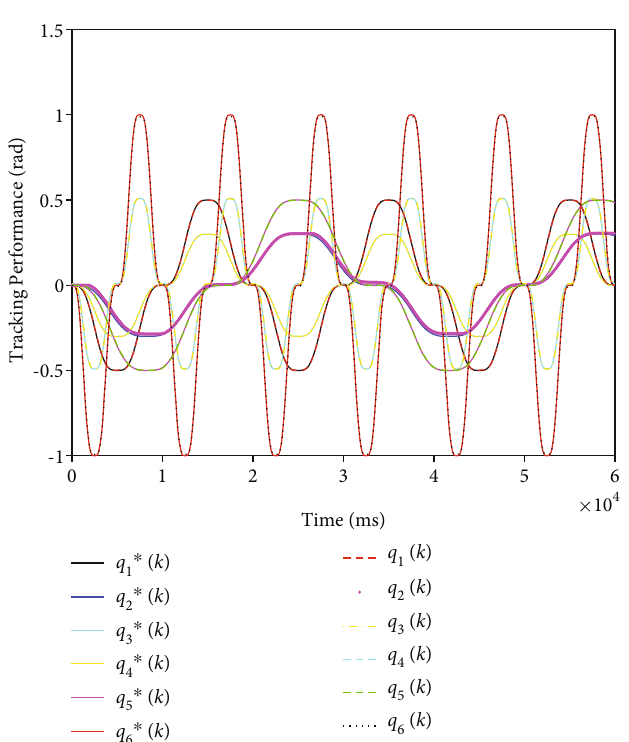
Figure 3: Tracking performance of each robotic joint controlled by variable structure